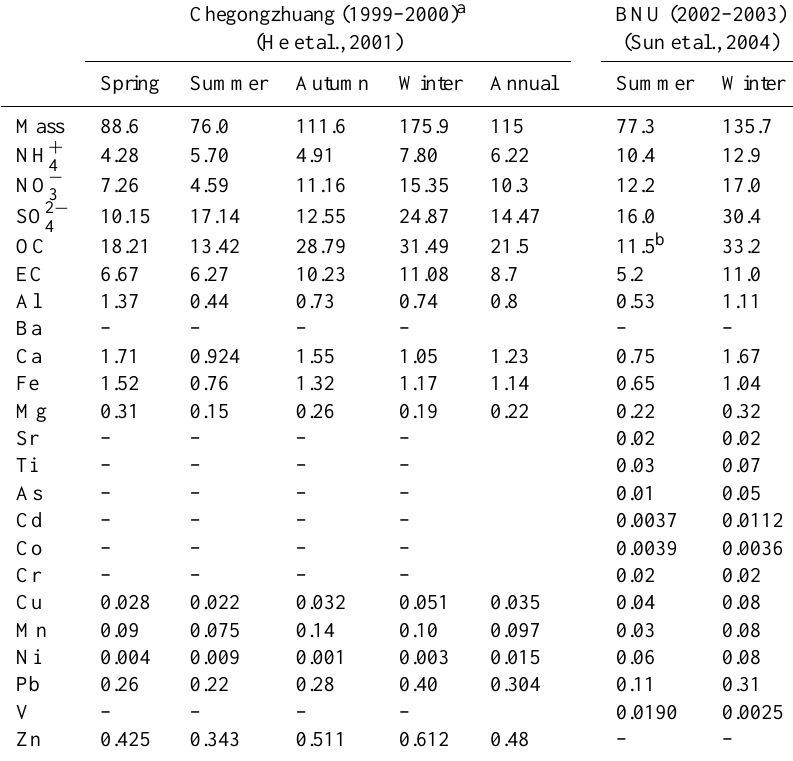
Table 9. Seasonal concentrations of PM 2 . 5 chemical species for Beijing in previous studies (µgm − 3 )